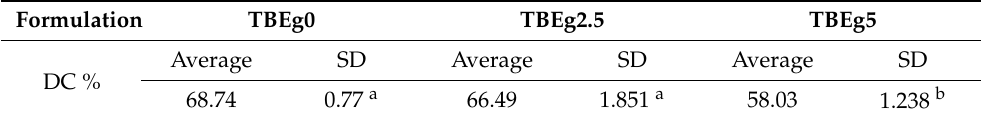
Table 3. The mean and standard deviation (SD) of TBEg’s composites degree of conversion (DC), ( n =